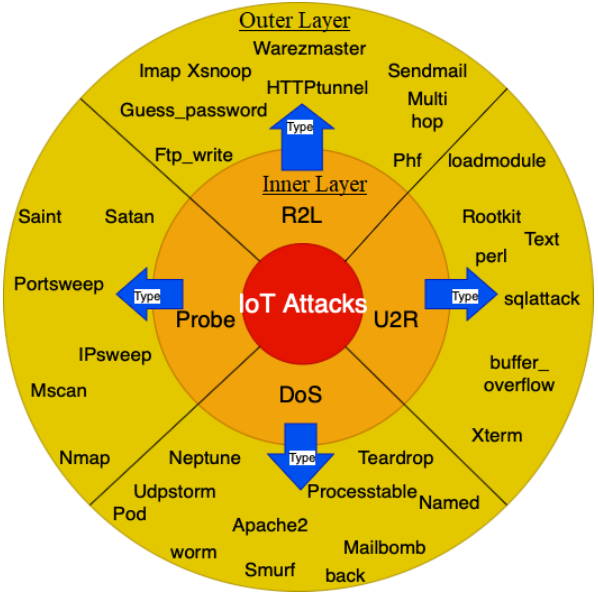
Figure 4. Layerwise NSL-KDD dataset